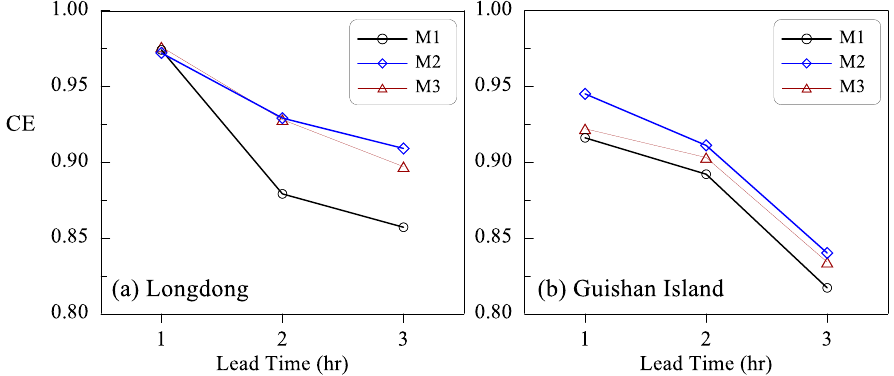
Figure 7. Forecasting performance in terms of coefficients of efficiency (CEs) during the validation phase for ( a ) Longdong and ( b ) Guishan Island.